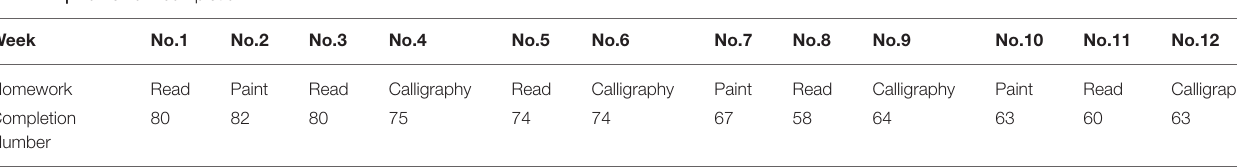
TABLE 4 | Homework completion.